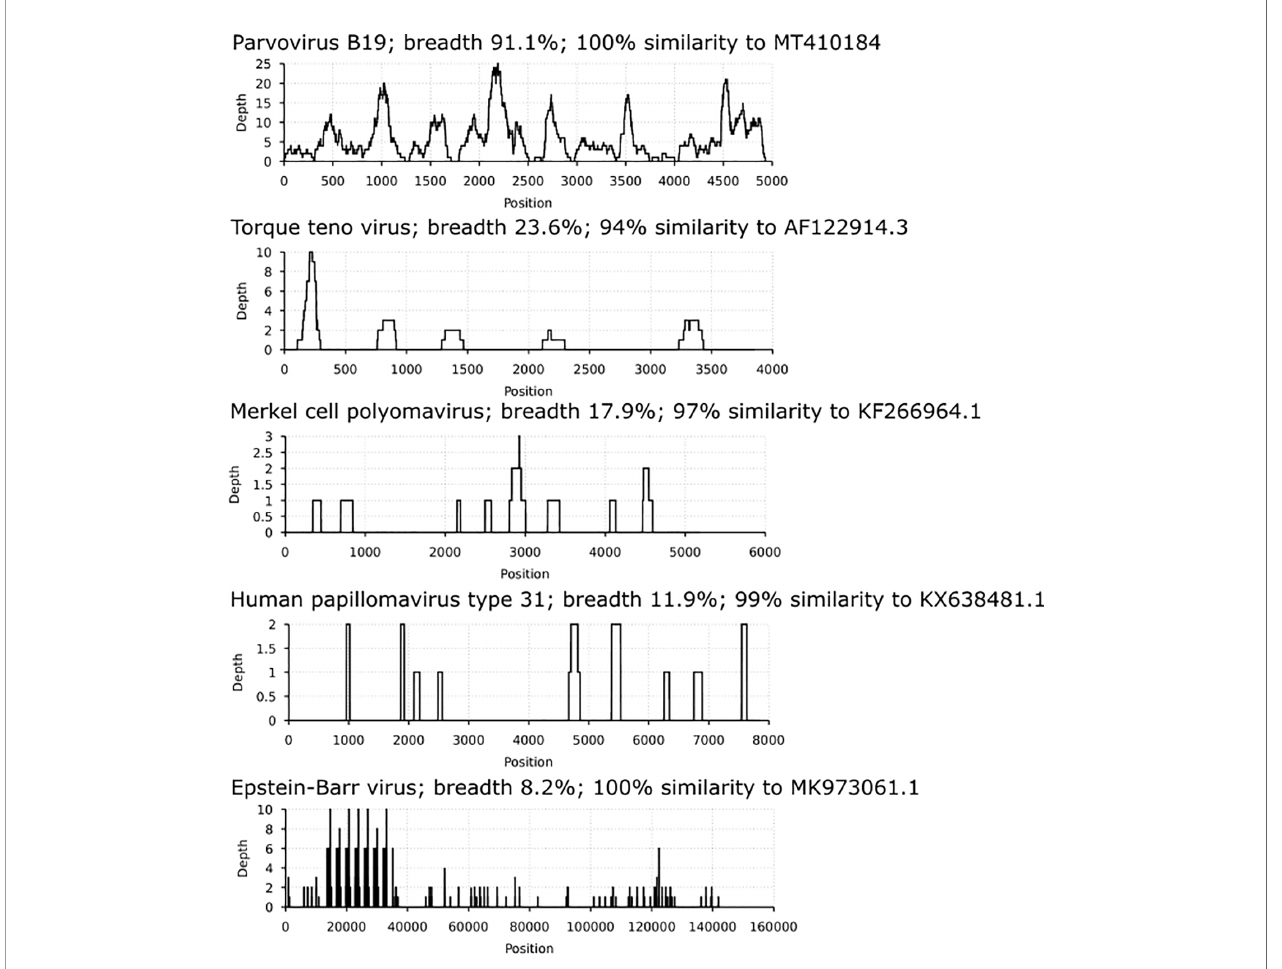
FIGURE 3 | Coverage pro fi les of reconstructed viral DNA sequences. In the x axis is the breadth coverage (= reads covering the noted viral reference) and in the y axis the depth (number of reads covering a speci fi c nucleotide/area). Represented are parvovirus B19, torque teno virus, Merkel cell polyomavirus, human papillomavirus type 31 and Epstein-Barr virus. Each pro fi le is speci fi ed by the virus name, breadth coverage and the genomic sequence similarity to its closest match by